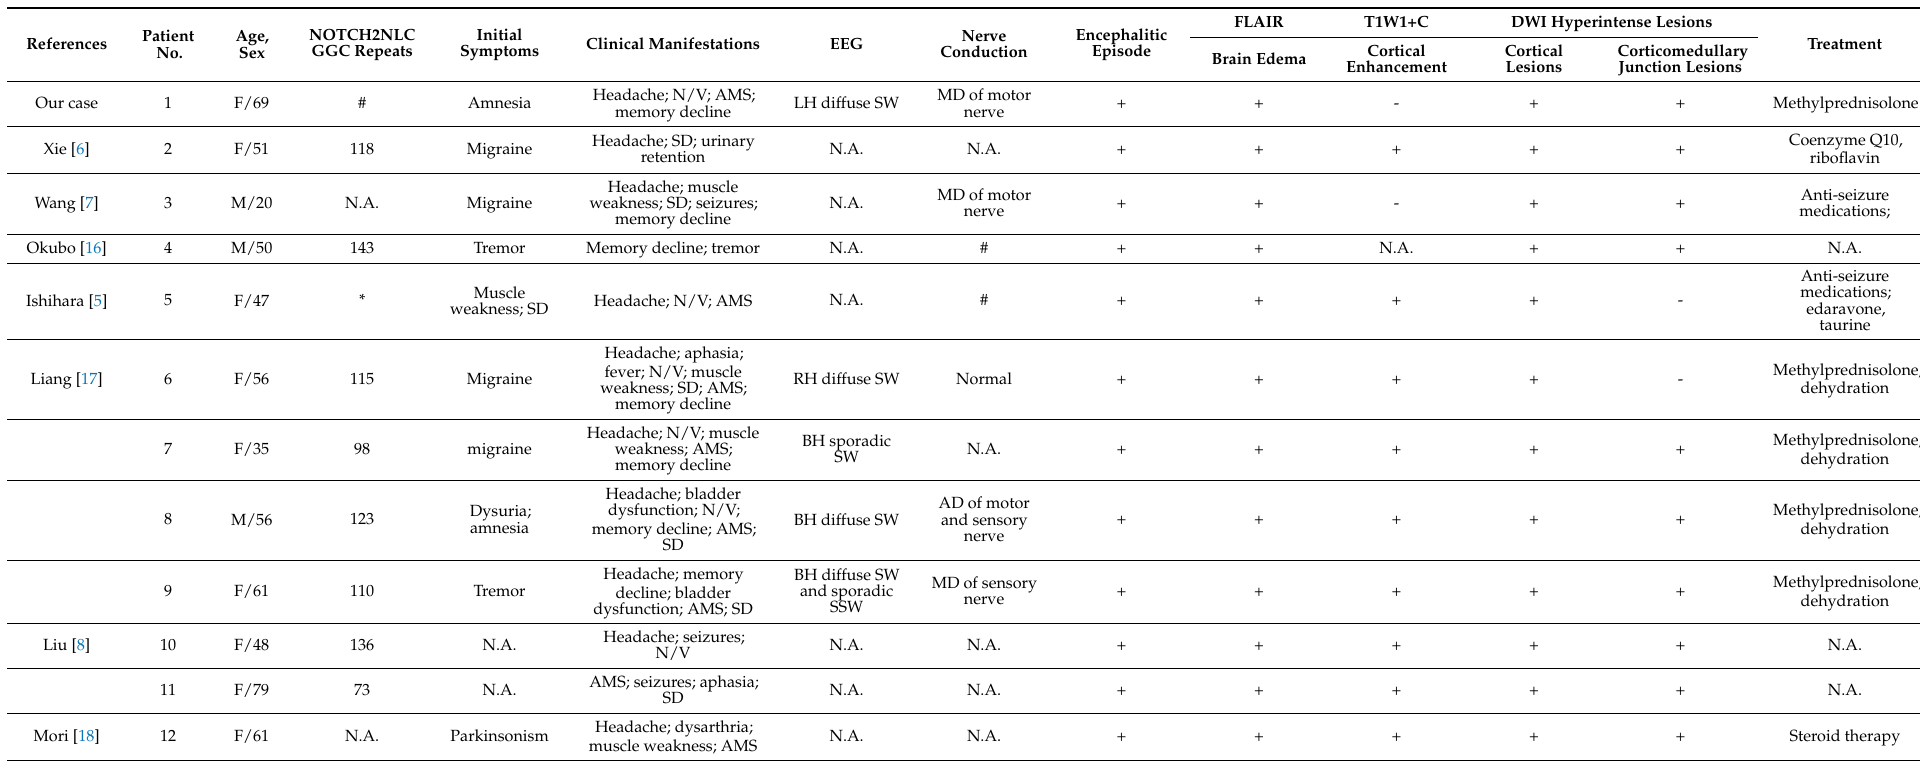
Table 1. The clinical characteristics of NIID patients with MELAS-like